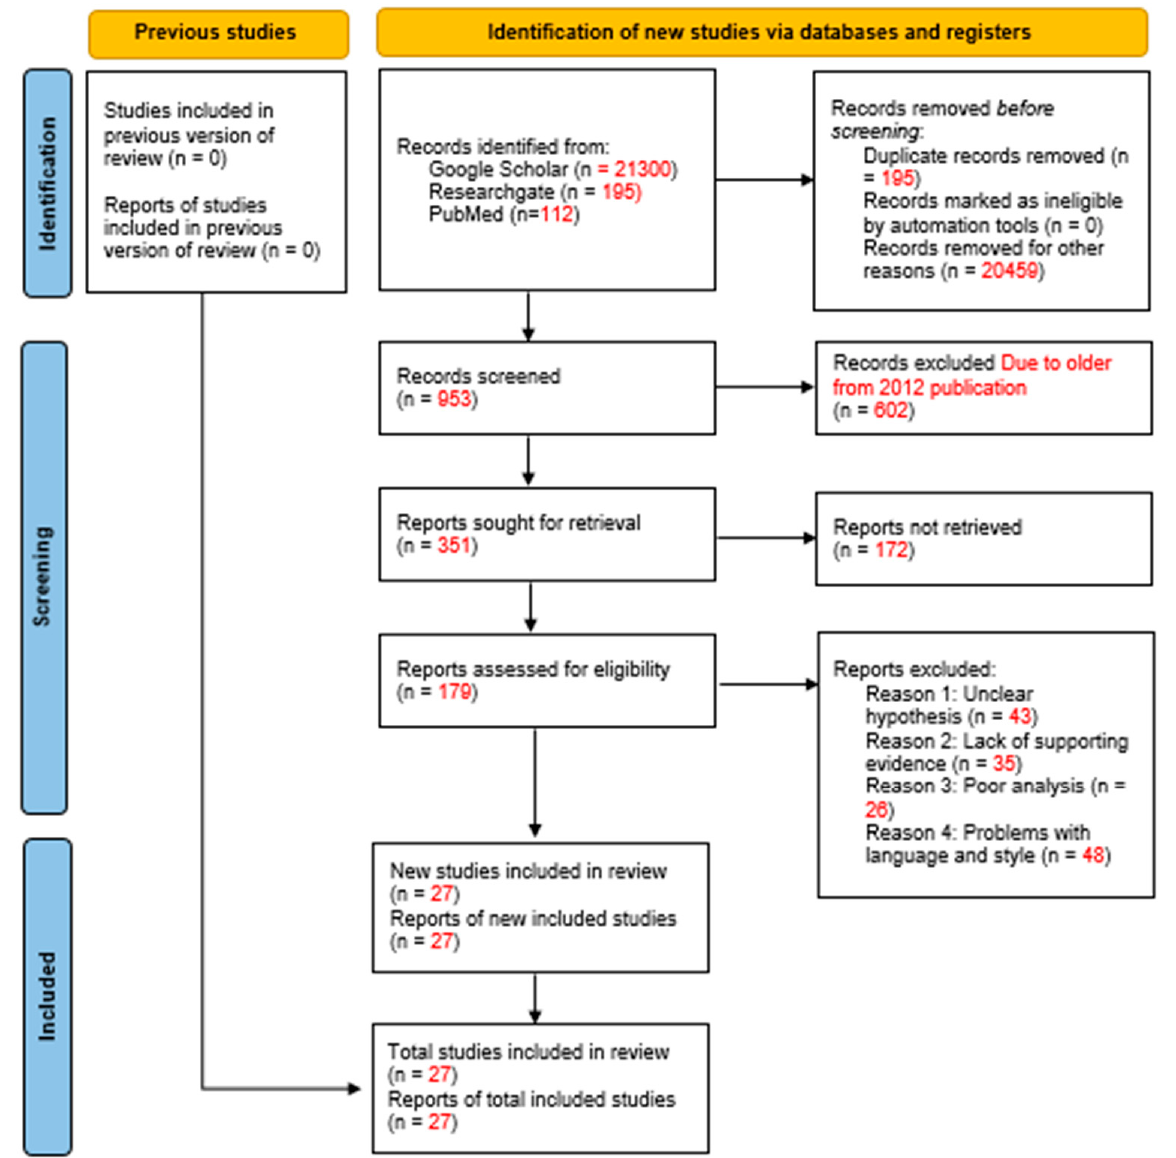
Figure 1. PRISMA for the first category (Artistic Behavior and NDs) .